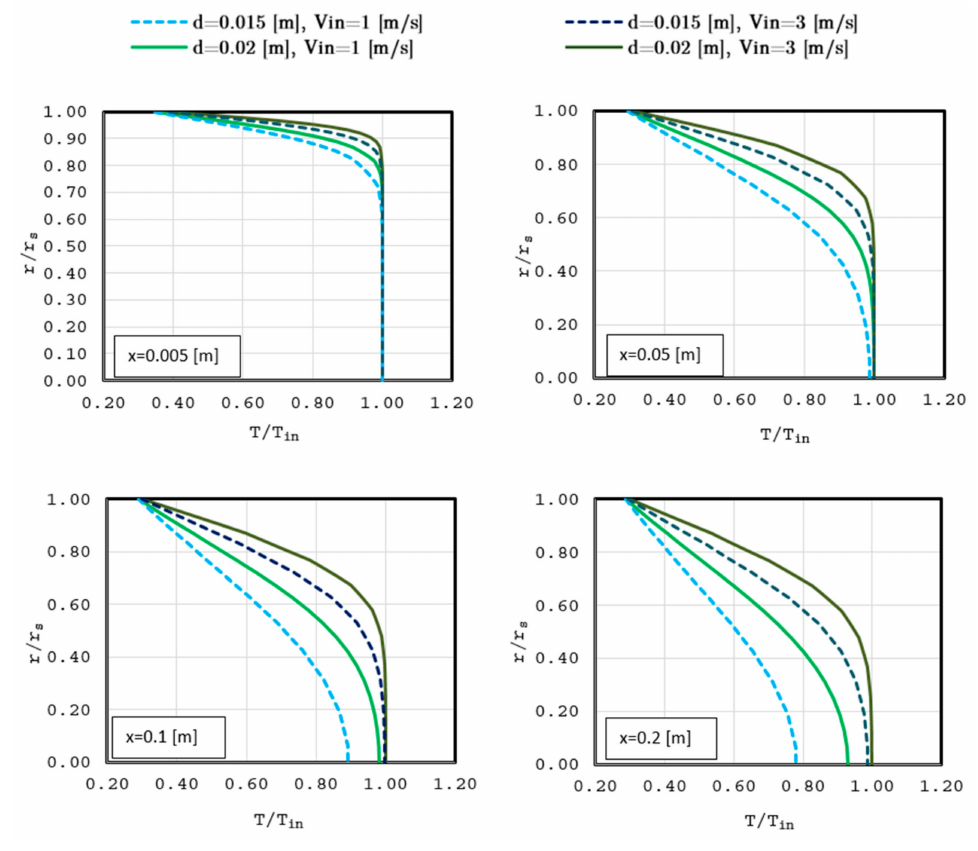
Figure 7. Results of the conjugate heat-transfer analysis: temperature profiles at di ff erent locations.